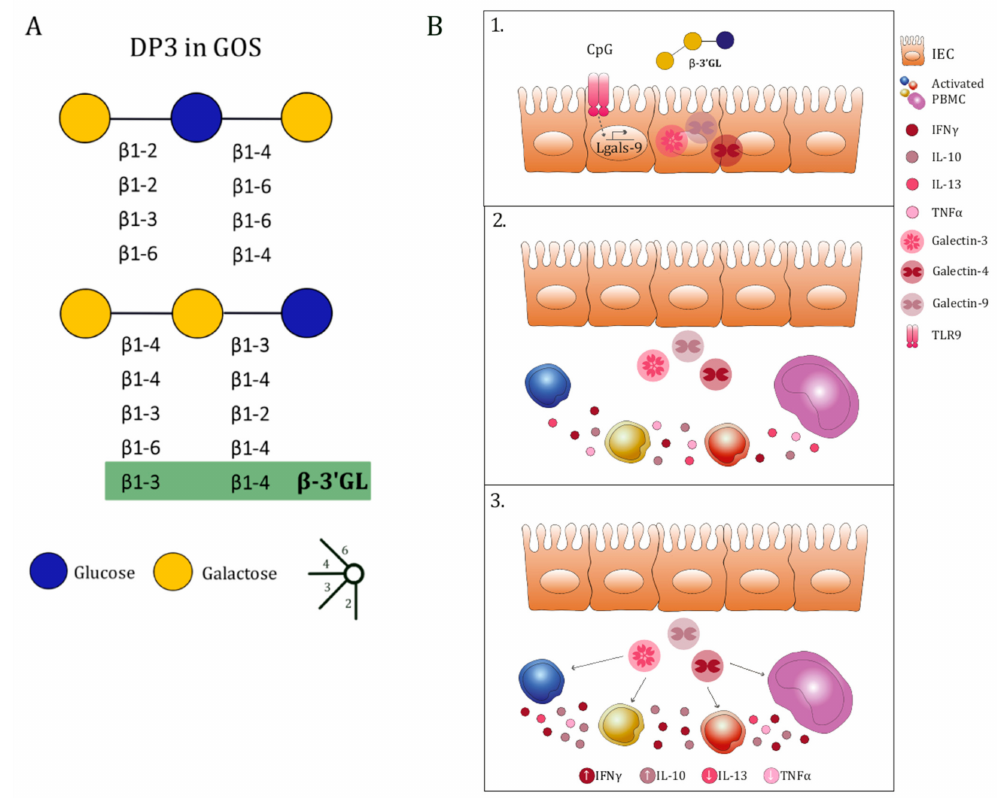
Figure 7. DP3-sized oligomers in GOS and description of the effects by β -3 (cid:48) GL and CpG in the IEC/PBMC co-culture model. DP3-sized structures present in GOS including β -3 (cid:48) GL are shown